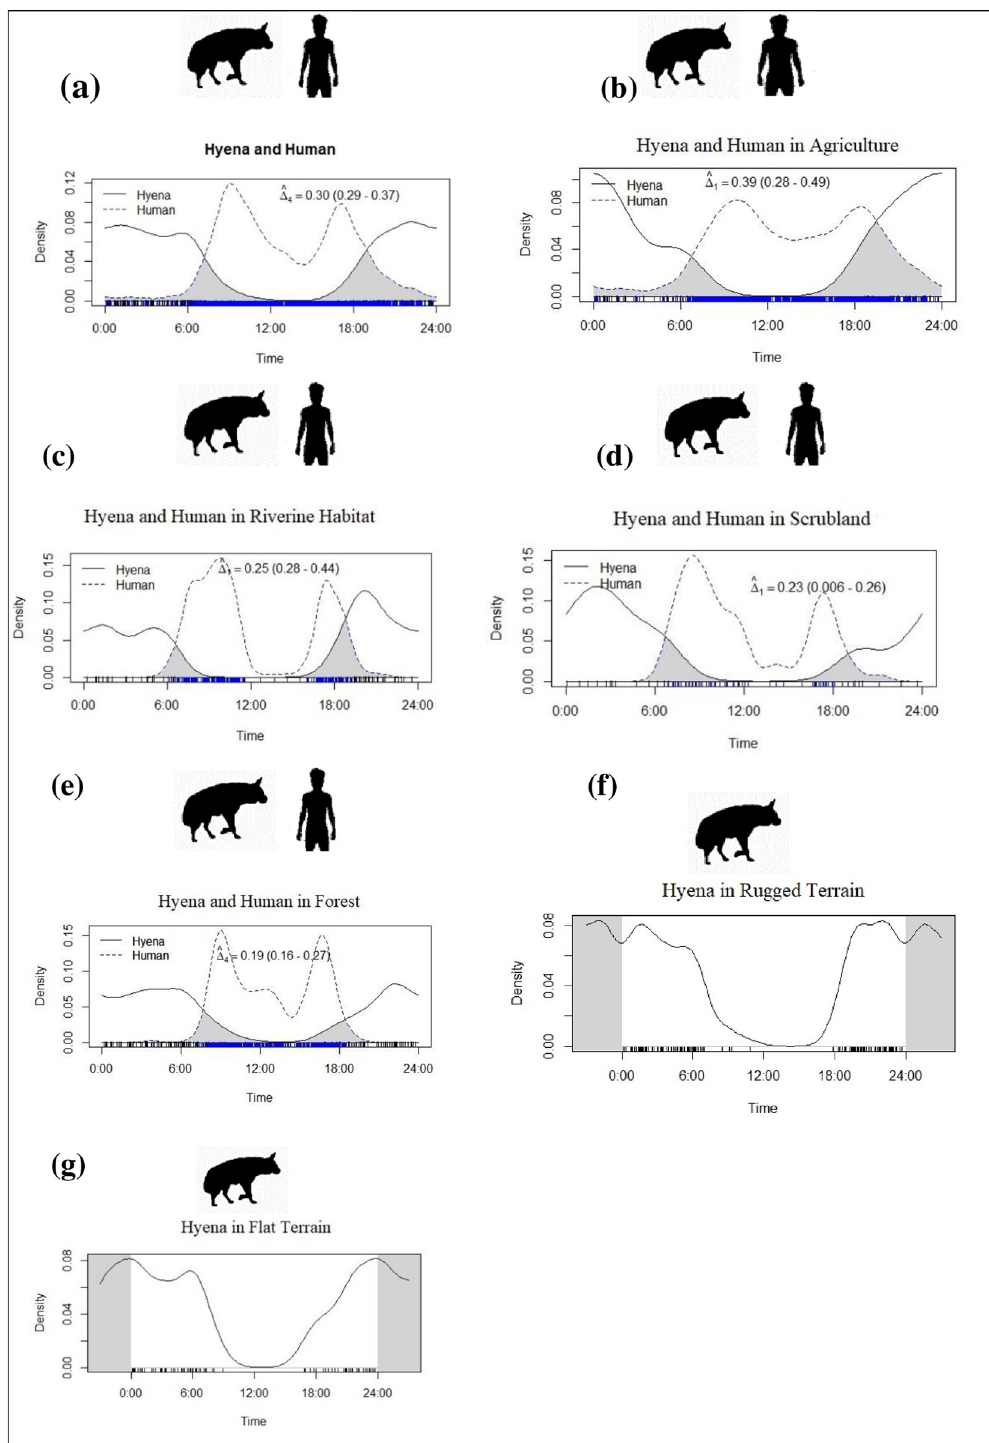
Fig 4. The kernel density function of activity and overlap plot of striped hyena and human in different land-use categories (a) along with human (b) agricultural area (c) riverine area (d) scrubland (e) forest (f) rugged terrain (g) flat terrain, in the human-dominated landscape of Sawai Mansingh Wildlife Sanctuary, Rajasthan.